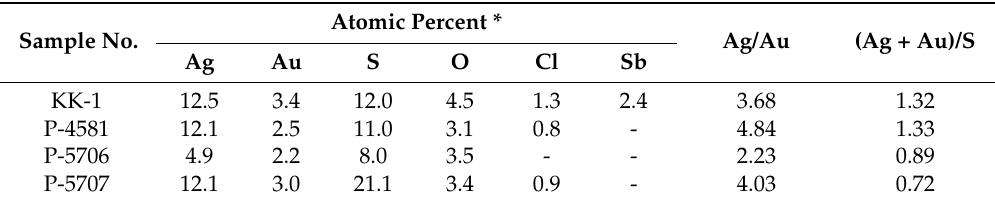
Table 3. Peculiarities of surface chemical composition of native gold samples from the Kvartsevaya Sopka deposit according to AES.